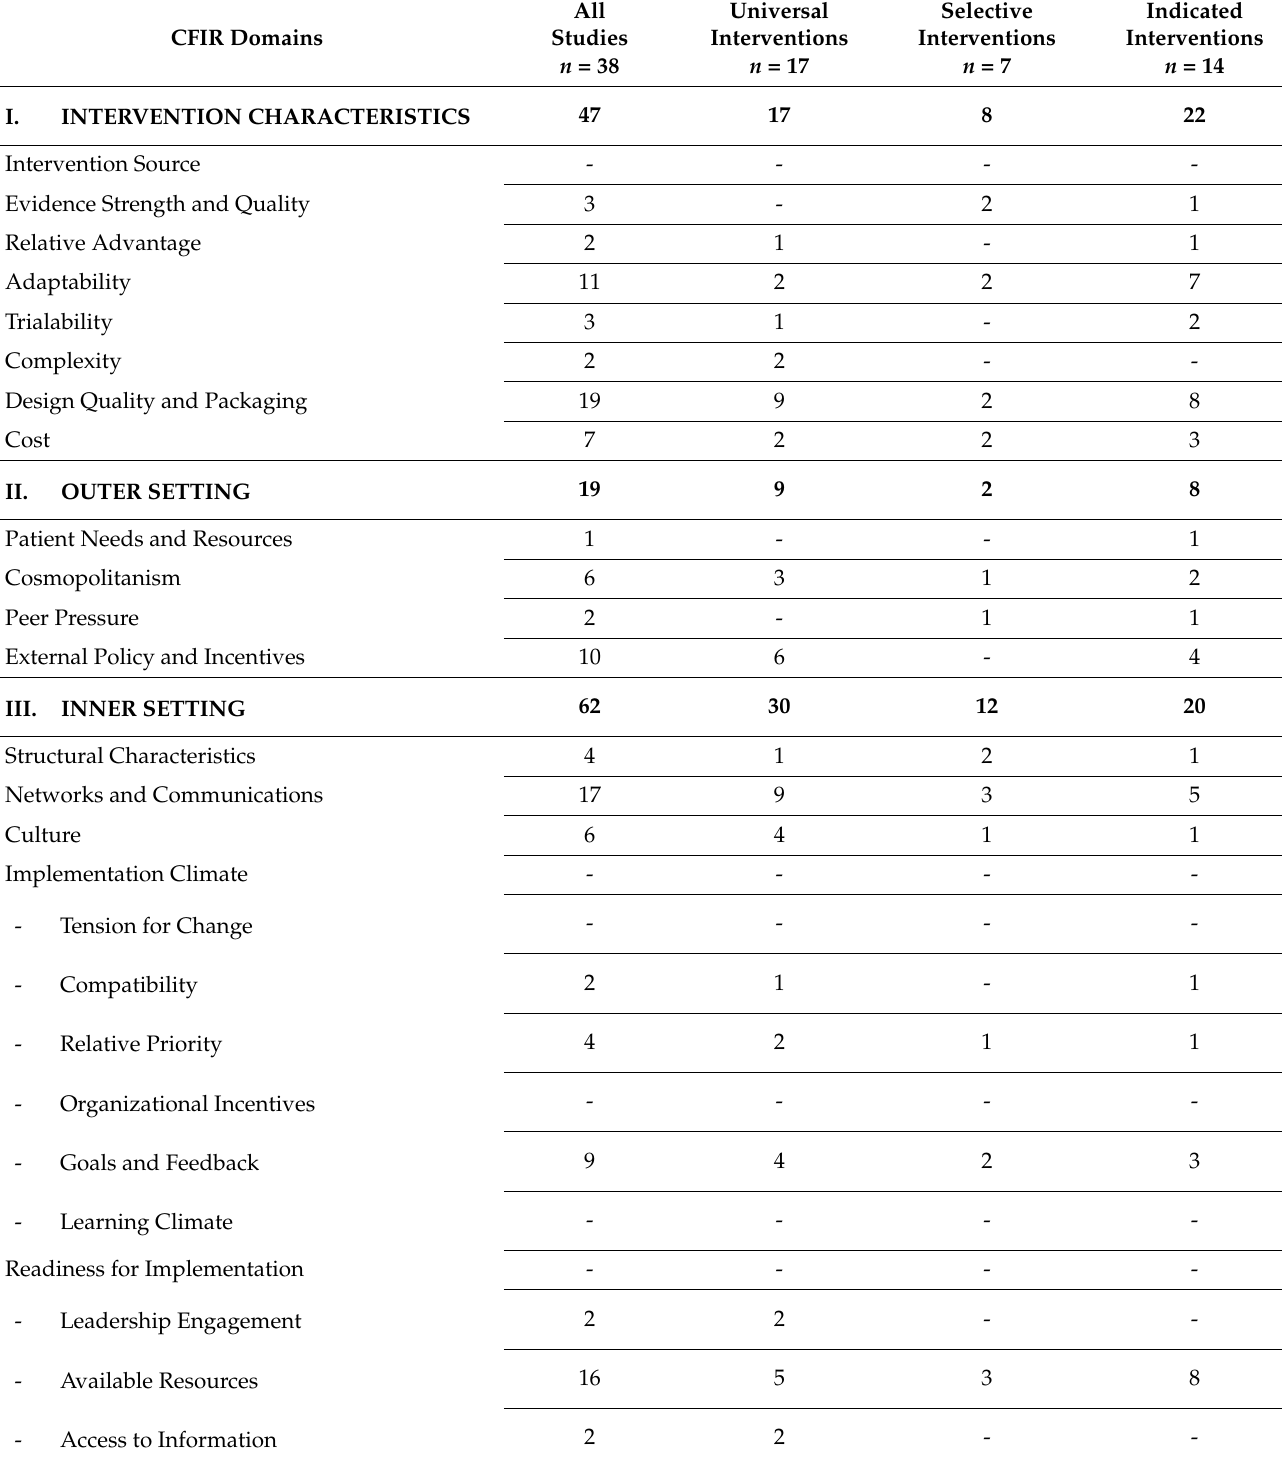
Table 2. Implementation factors related to